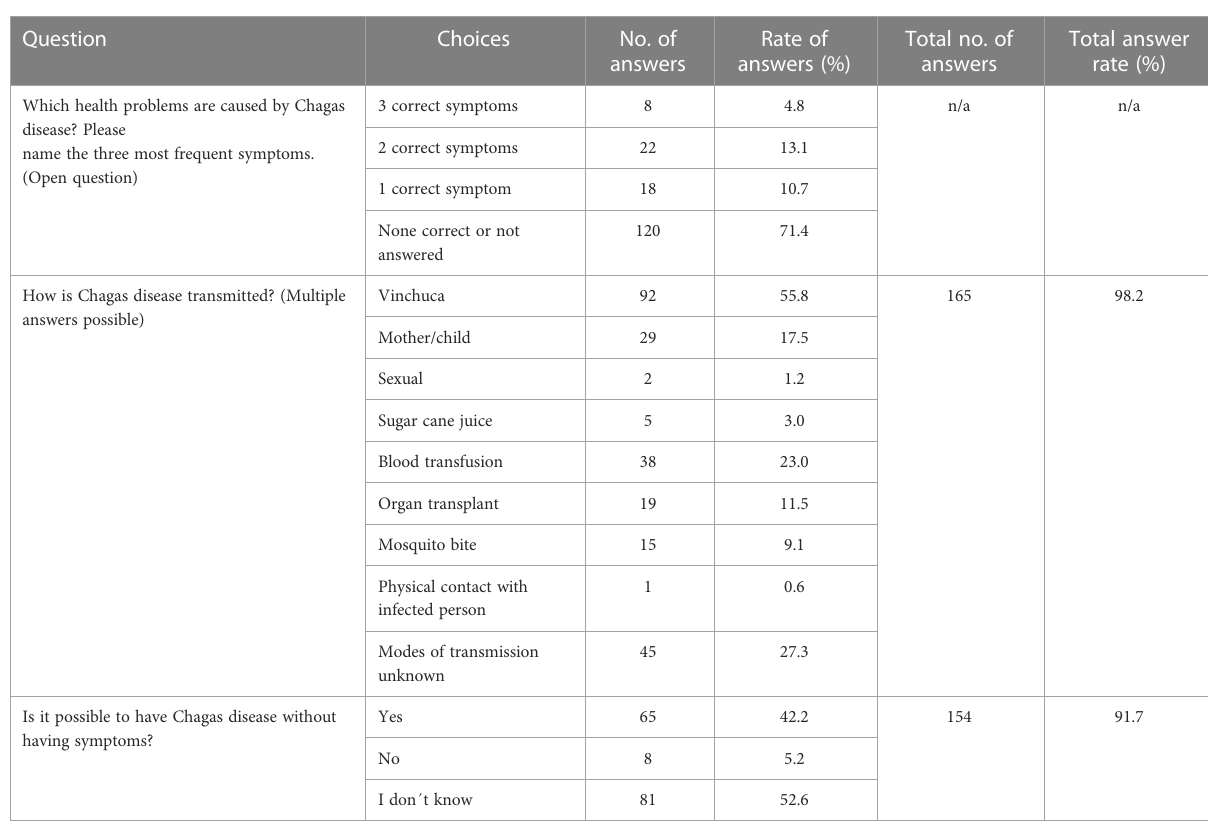
TABLE 3 Knowledge about Chagas